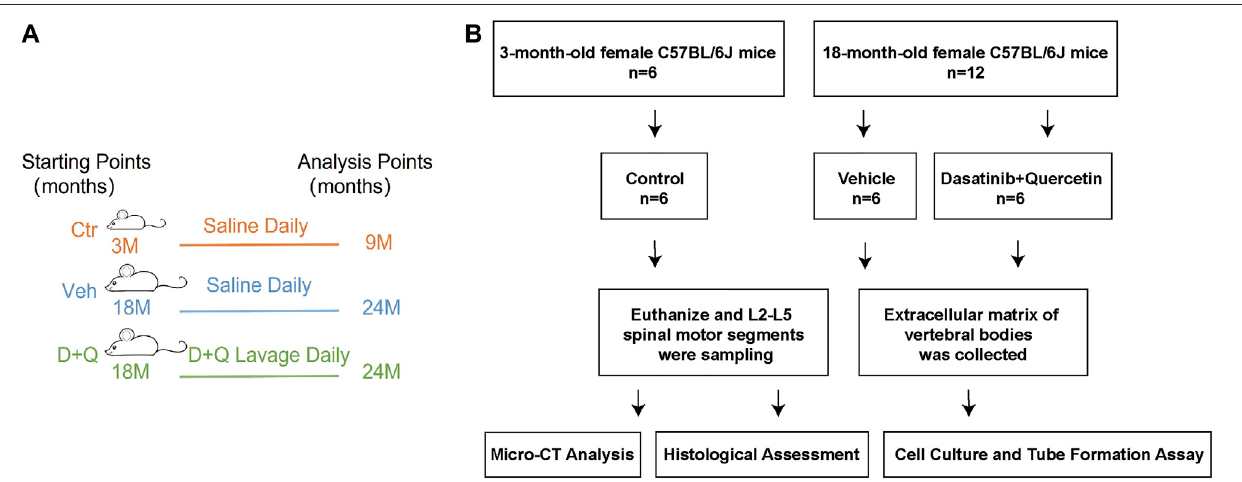
FIGURE 1 | Overall experimental design. (A) Schematic showing research time points of aged mice model in this study. (B) Experimental fl ow chart. Micro-CT, microcomputed tomography; Ctr, control group (3-month-old mice, saline); Veh, vehicle group (18-month-old mice, saline); D + Q, dasatinib and quercetin group (18- month-old mice, 5 mg/kg/day dasatinib plus 50 mg/kg/day